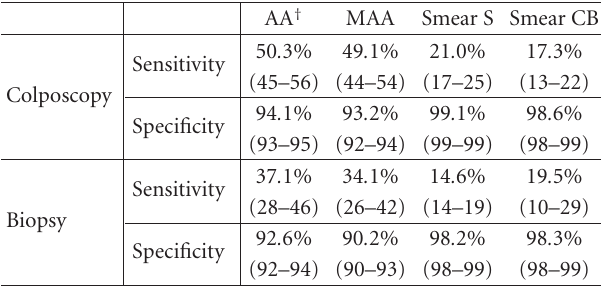
Table 3: Comparison between acetic acid visualisation and Pap smears.